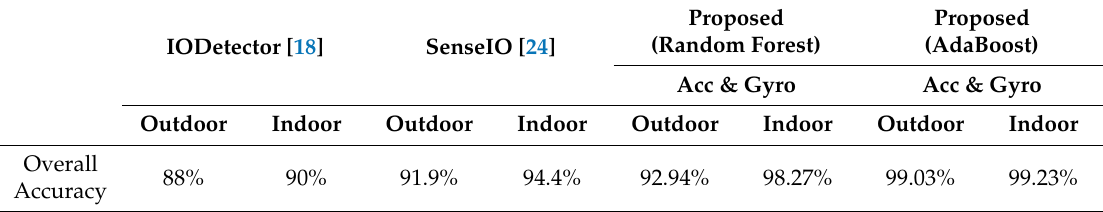
Table 9. The overall accuracy